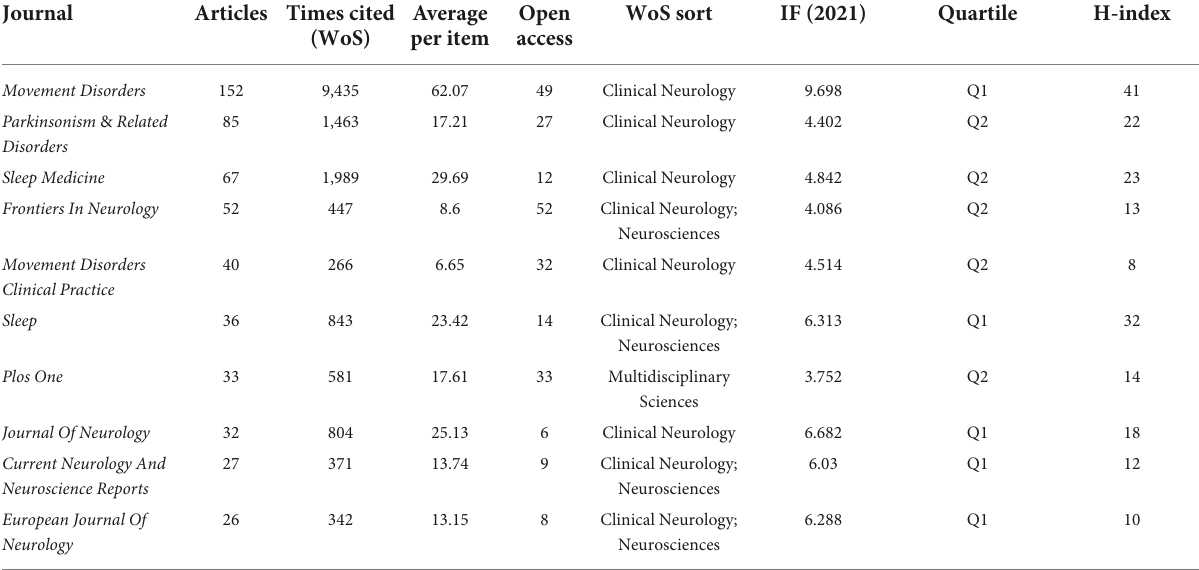
TABLE 1 The top 10 journals in the field of exercise for movement